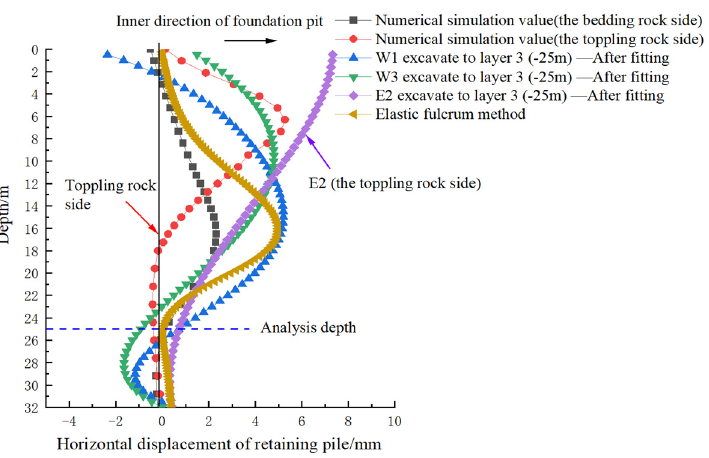
Figure 22. Trend table of horizontal displacement variations for various calculation methods.